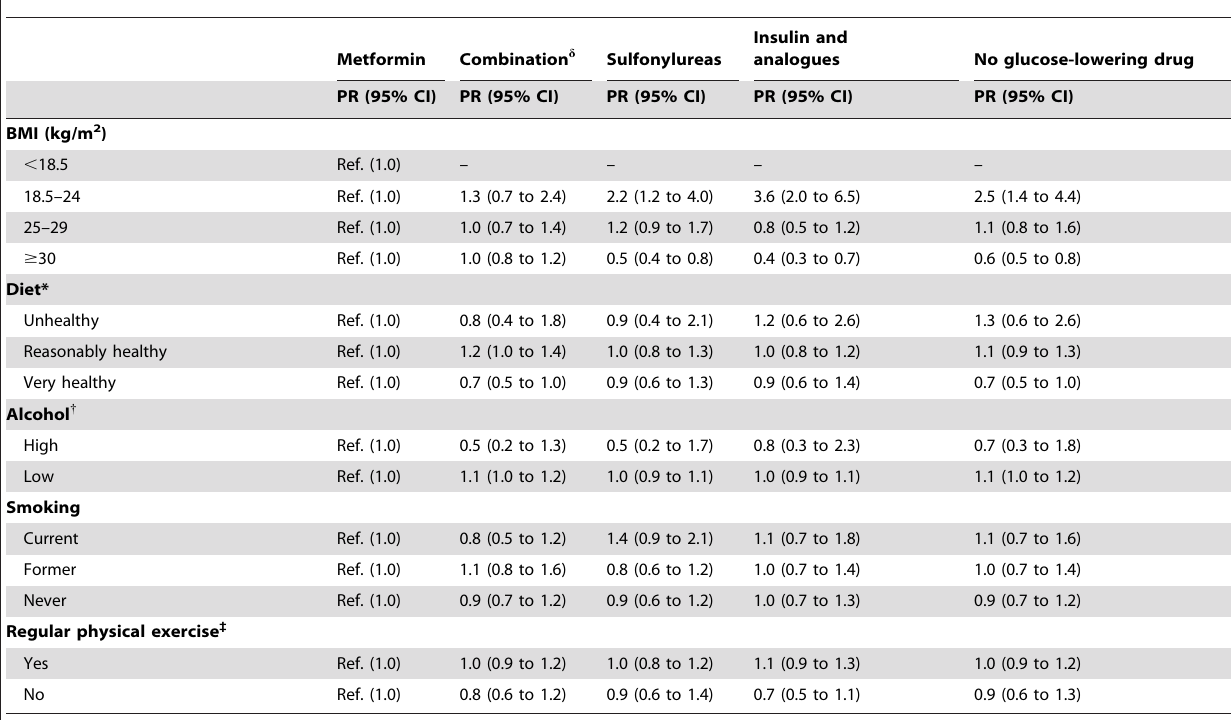
Table 6. Age- and gender-standardized prevalence ratios (PRs) of lifestyle factors according to glucose-lowering